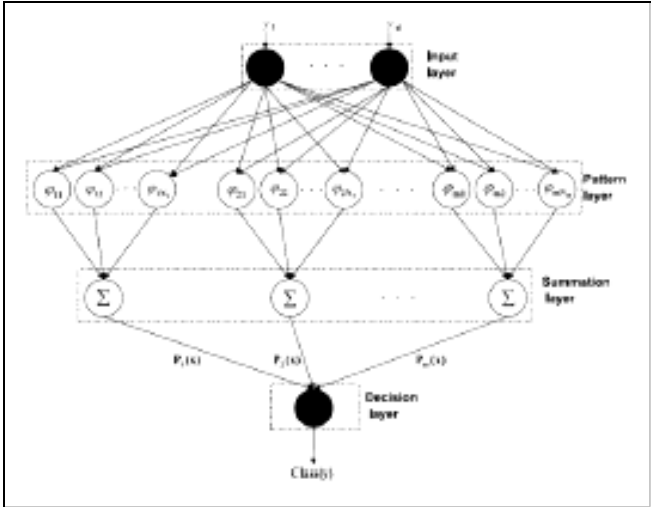
Figura 2: Arquitectura de la Red Neuronal Probabilística. Fuente: Los Autores,